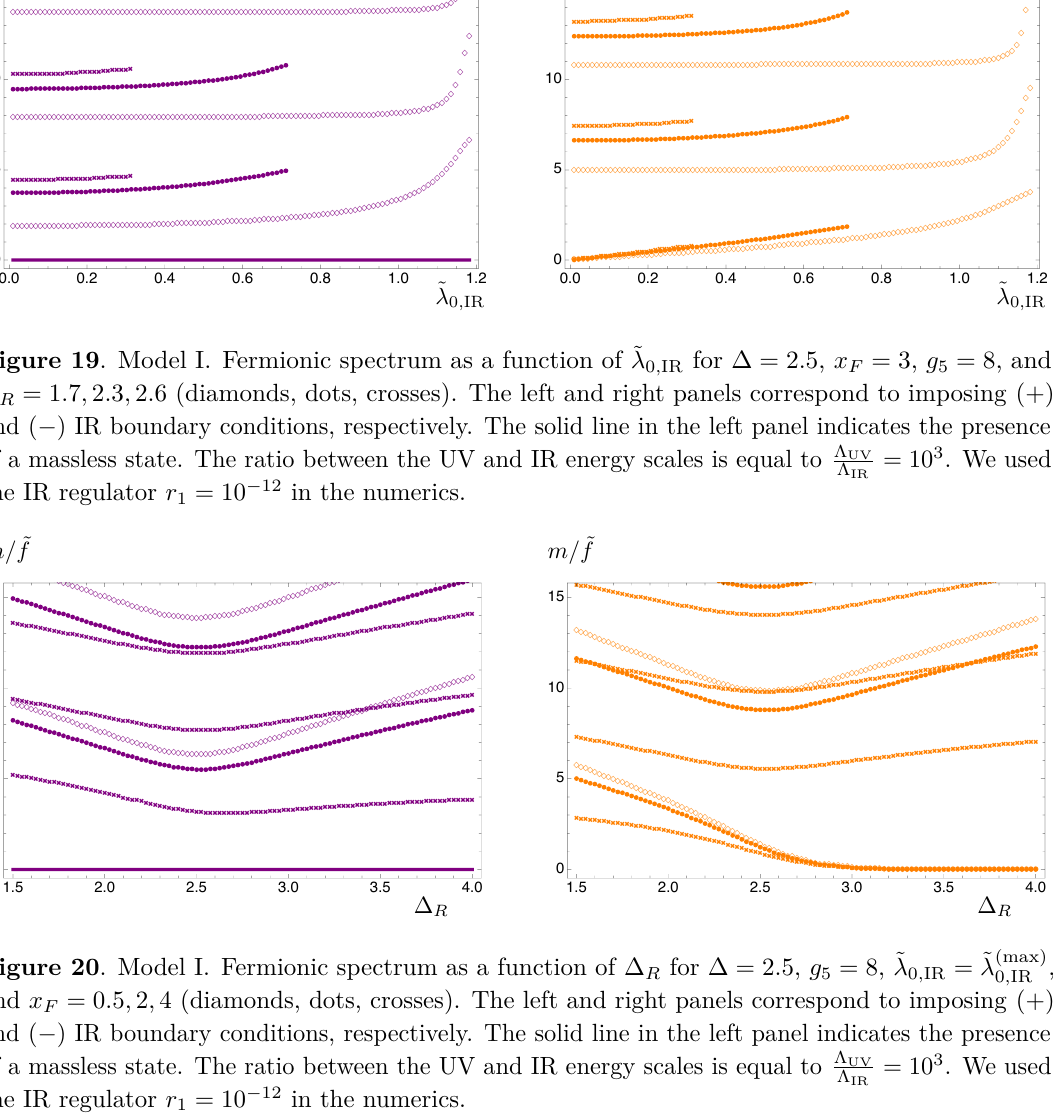
, 0 , IR = 10 3 . We used Λ IR